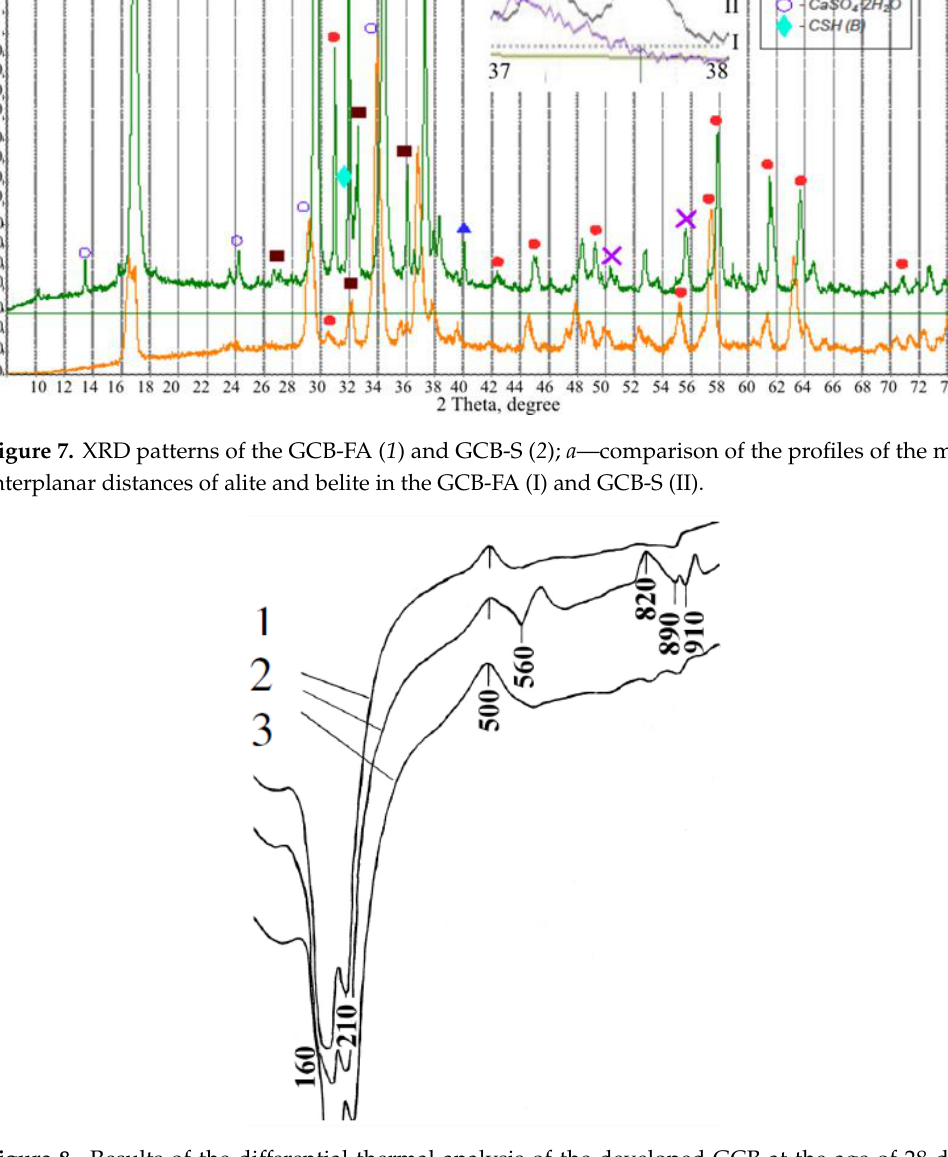
Figure 8. Results of the differential thermal analysis of the developed GCB at the age of 28 days. 1— 1—GCB; 2—GCB-FA; 3—GCB-S. Three-digit numbers represent degrees GCB; 2—GCB-FA; 3—GCB-S. Three-digit numbers represent degrees Celsius